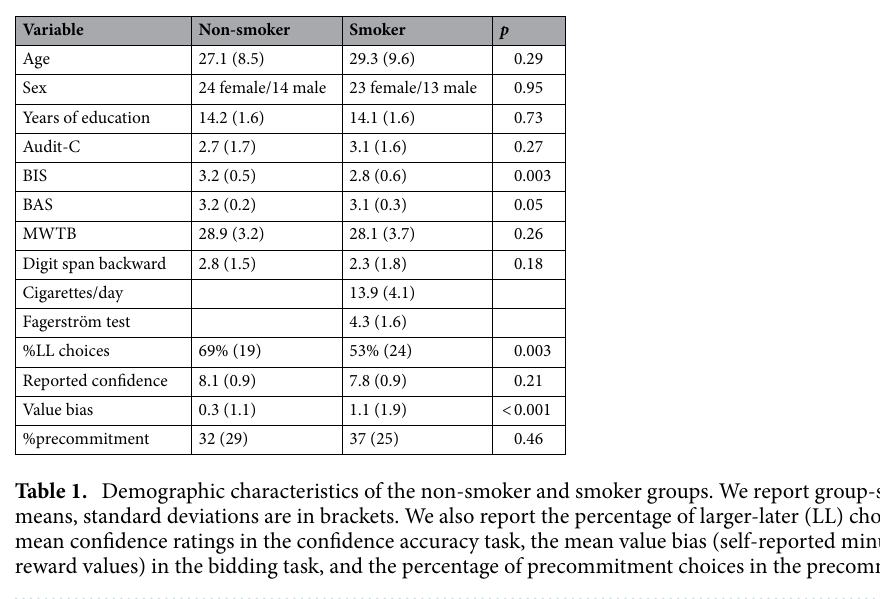
terms. The strength of the interaction between DV (as measure of objective decision uncertainty) and confidence (subjective uncertainty) is an indicator of metacognitive accuracy. This is because participants should be more confident that they made the best choice the larger the difference in subjective value between the options, and the DV × Confidence interaction measures participants’ ability to track and report the consistency of their deci- sions. Smokers made significantly fewer LL choices than non-smokers, HDI mean = − 3.33, HDI 95% = [− 5.53; − 1.35]. Moreover, the main effects of both DV, HDI mean = 5.76, HDI 95% = [4.87; 6.76], and confidence, HDI mean = 1.08,